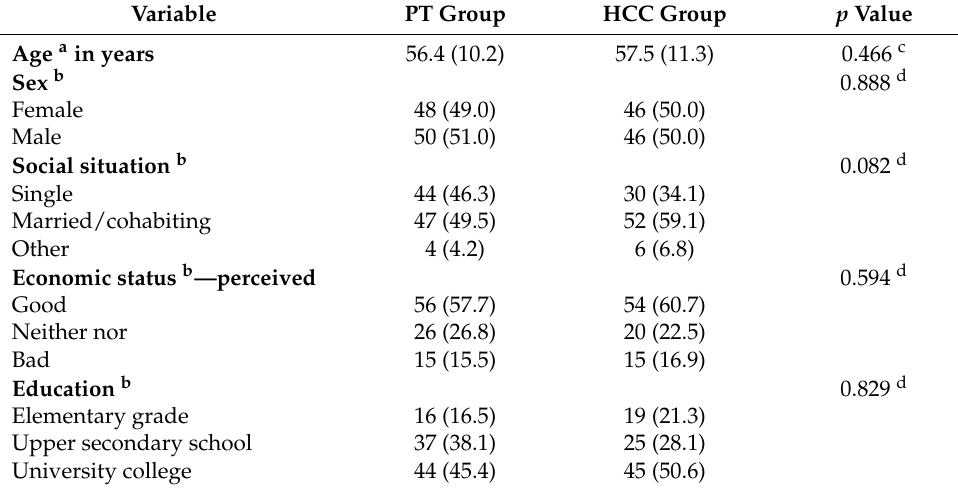
Table 1. Baseline characteristics of the patients in the physiotherapist (PT) and healthcare center (HCC)